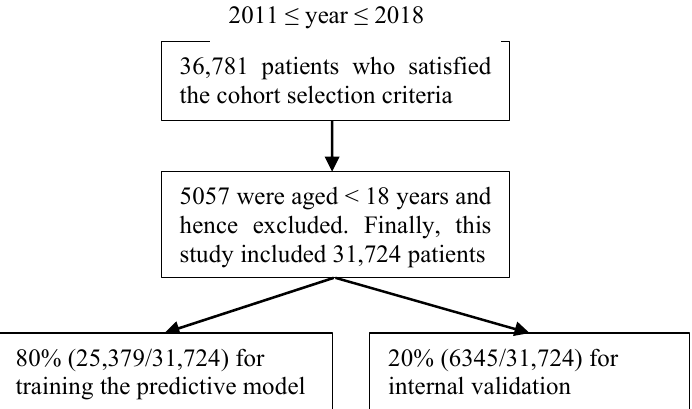
Figure 1. The patient cohort in the